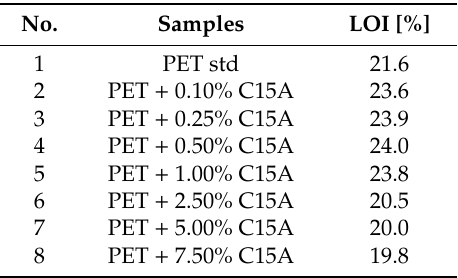
Table 1. Limiting oxygen index (LOI) values of studied fibers.